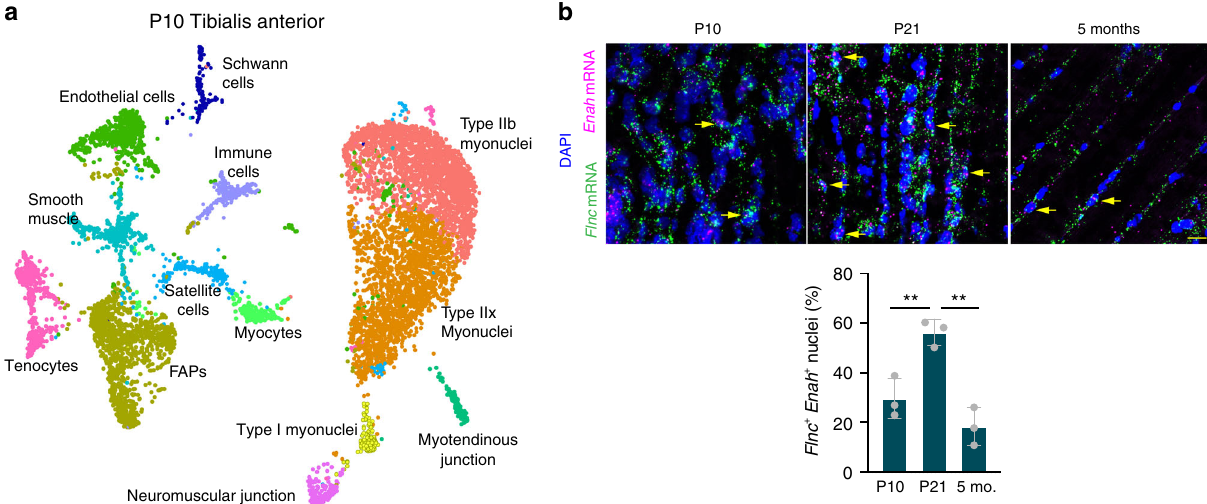
Fig. 3 Myonuclear transcriptional states exhibit temporal speci fi city in development. a UMAP representing snRNA-seq data from a postnatal (P) day 10 tibialis anterior shows the presence of an activated muscle progenitor population (myocytes) but the absence of de fi ned sarcomere myonuclear states. b smRNA-FISH for Flnc and Enah shows an expansion of sarcomere assembly state myonuclei in P21 tibialis anterior compared to P10 and adult muscle. Flnc + Enah + nuclei were quanti fi ed at each timepoint ( n = 3). Data are presented as mean ± standard deviation. A one-way ANOVA with Tukey post-hoc comparison was used to determine statistical signi fi cance, ** P < 0.01. Scale bar: 20 μ m. Source data are provided as a Source Data fi